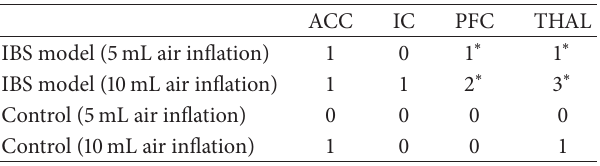
Table 1: Activation of visceral pain-related areas in rats.